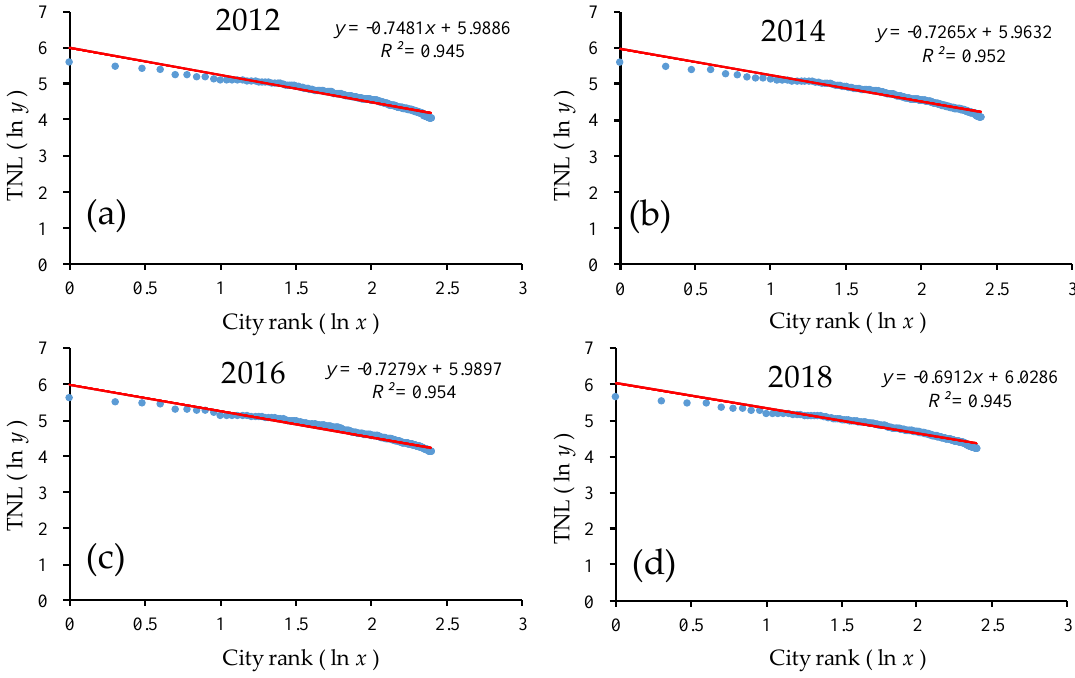
Figure 10. The ln-ln plot of the rank–size of the urban development for the top 250 prefectures. Line regression of ( a ) TNL and ranking of the top 250 prefectures in 2012; ( b ) TNL and ranking of the top 250 prefectures in 2014; ( c ) TNL and ranking of the top 250 prefectures in 2016; ( d ) TNL and ranking of the top 250 prefectures in 2018. Table 3. The Zipf law analysis at the prefectural level in China from 2012 to 2018.